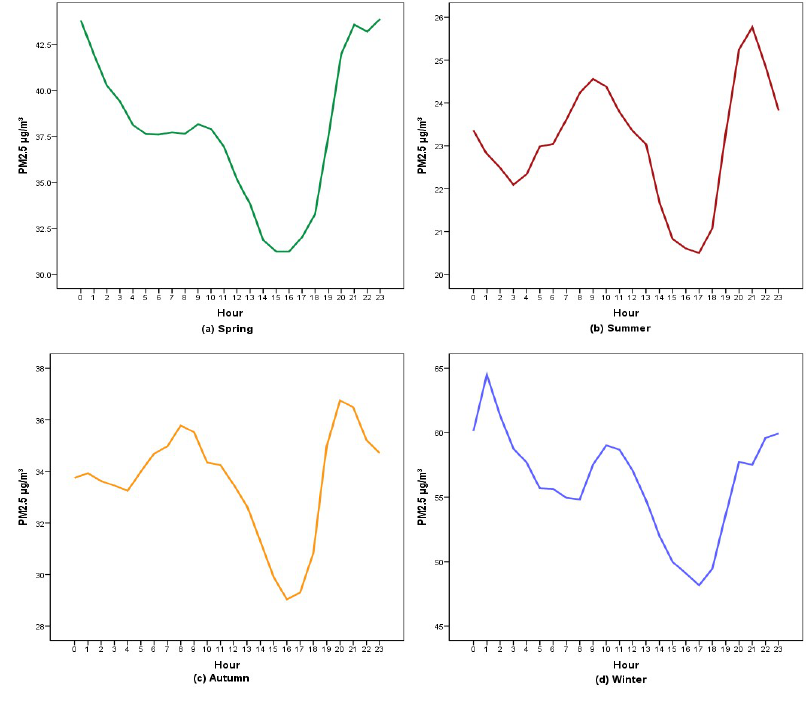
Fig. 2 Seasonal diurnal variation of PM